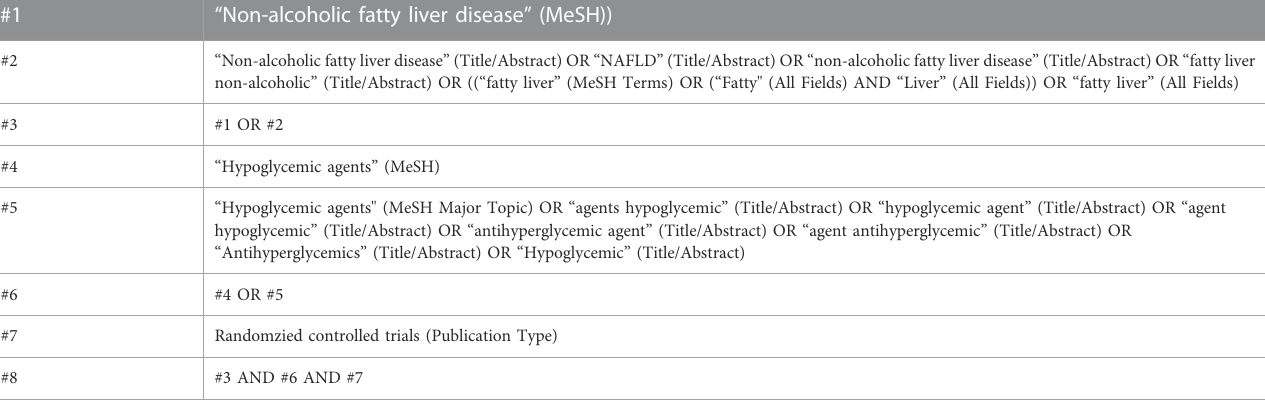
TABLE 1 Search strategy on PubMed. “ Non-alcoholic fatty liver disease ”